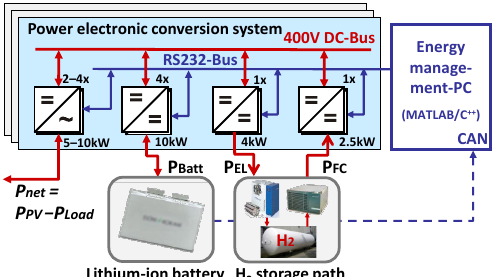
Figure 1. Topology of autonomous PV hybrid system with battery and H 2 storage